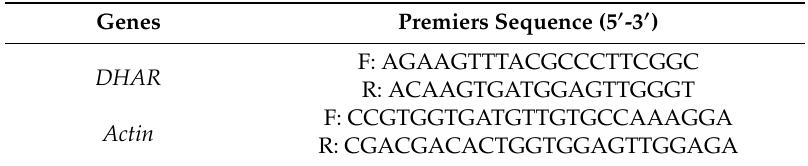
Table 5. Cont. Genes Premiers Sequence (5 (cid:48) -3 (cid:48) )